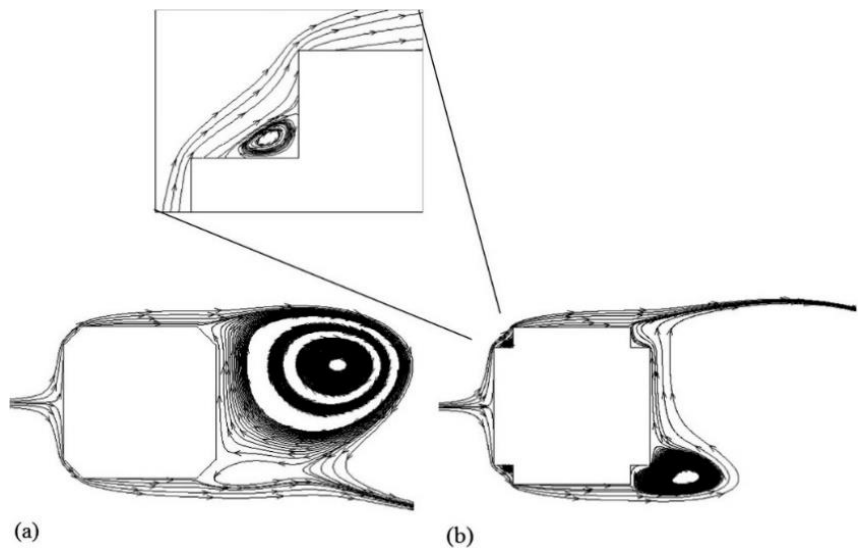
Figure 5. Streamlines around ( a ) chamfered and ( b ) cut corner cylinder at Re = 200; figure reprinted from Ambreen and Kim [38] Copyright (2018), with permission from Elsevier.